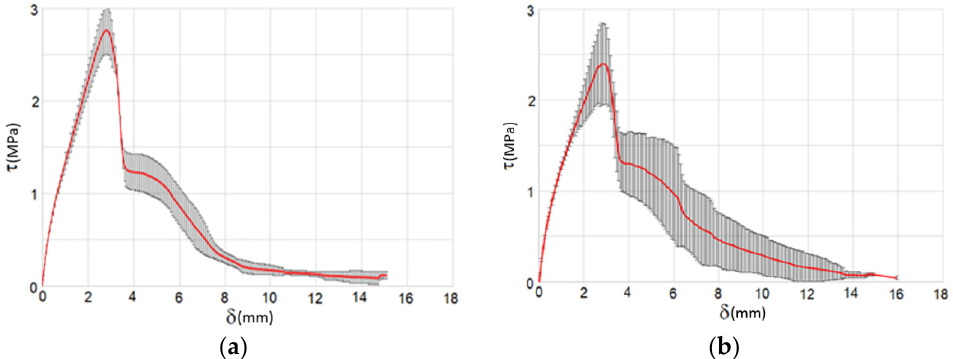
Figure 16. Results of the bonding DP490 obtained during the shear strength test: ( a ) samples without aging, ( b ) samples after aging.